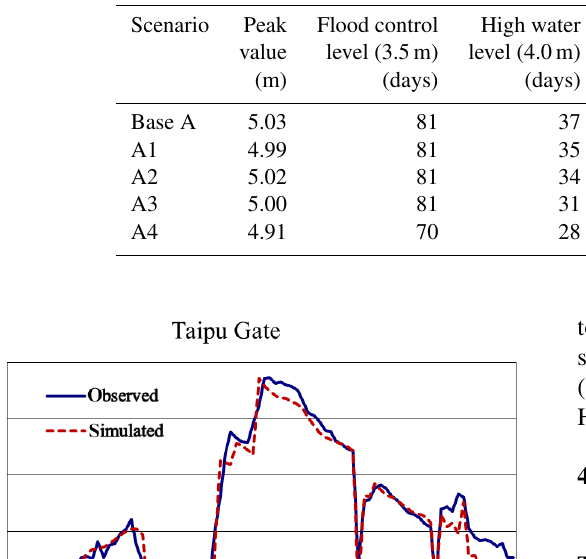
Table 2. Peak lake water levels and the duration (the number of days) from June to August of 1999 when lake water levels are higher than a certain control level under the five scenarios considered in this study.